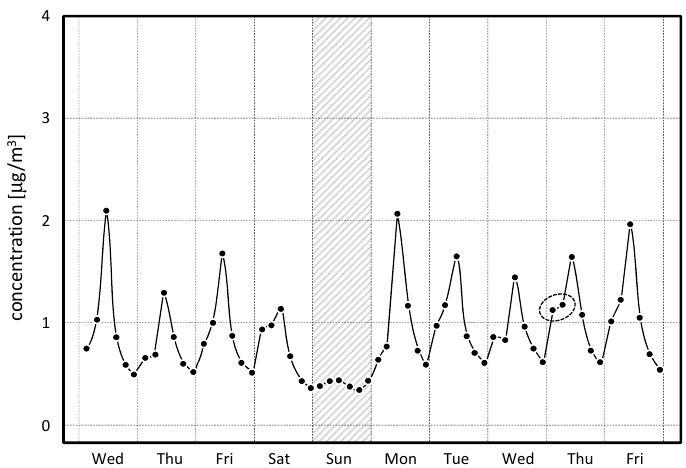
Figure 8. Weekly campaign on 13–22 April 2016. The daily evolution (sampled every 4 h) of the retrieved PM10 concentration points out a recurrent behaviour of the deposit, present in all the open days. Both effects describe anthropic influences on the quality of the air inside the museum. The very small fluctuation in the PM10 concentration was observed on Sunday.